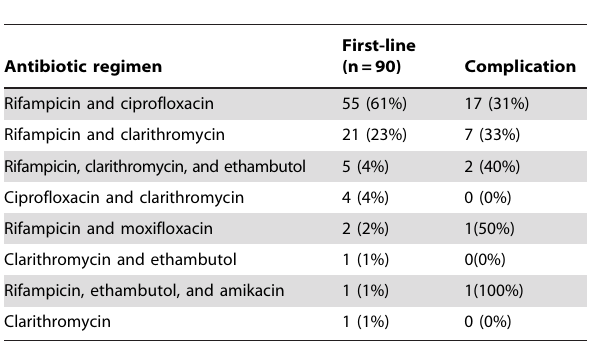
Table 1. First-line antibiotic regimens and complication rates.